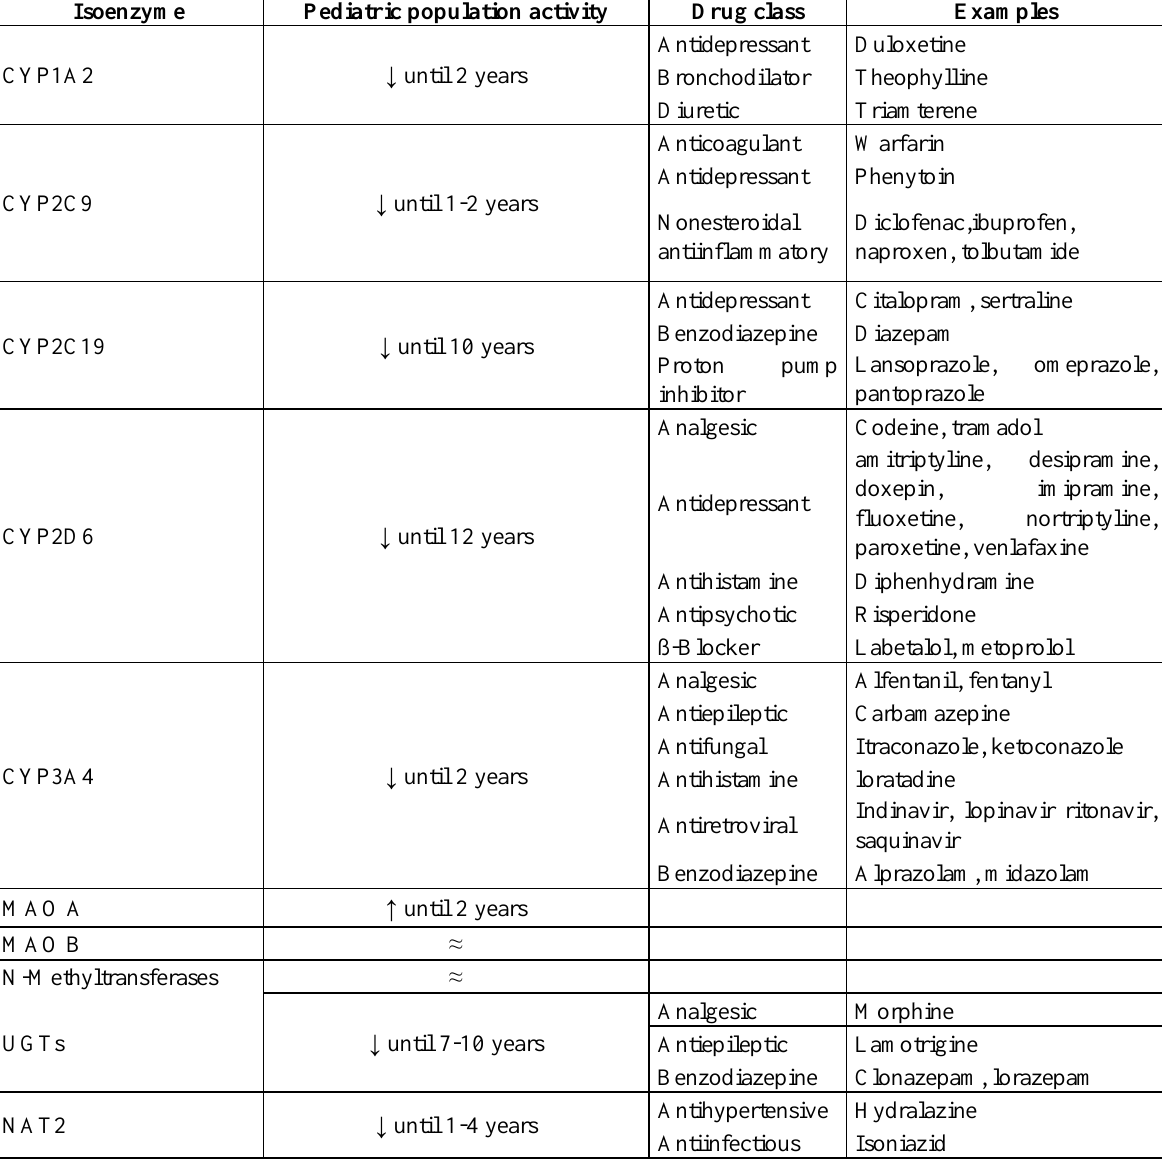
Table 3. Isoenzyme activity in pediatric population compared to adults and